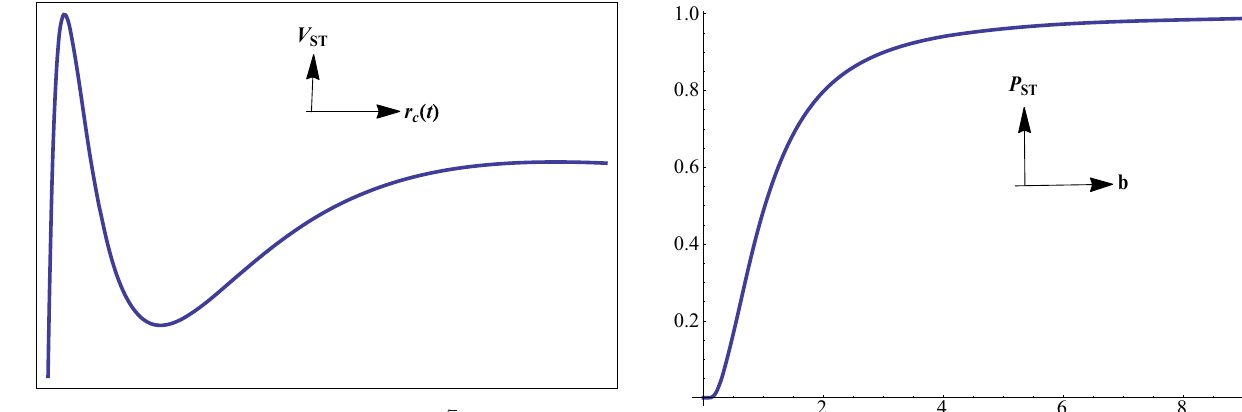
√ 2 , k = M = 1 ,(cid:11) = 3